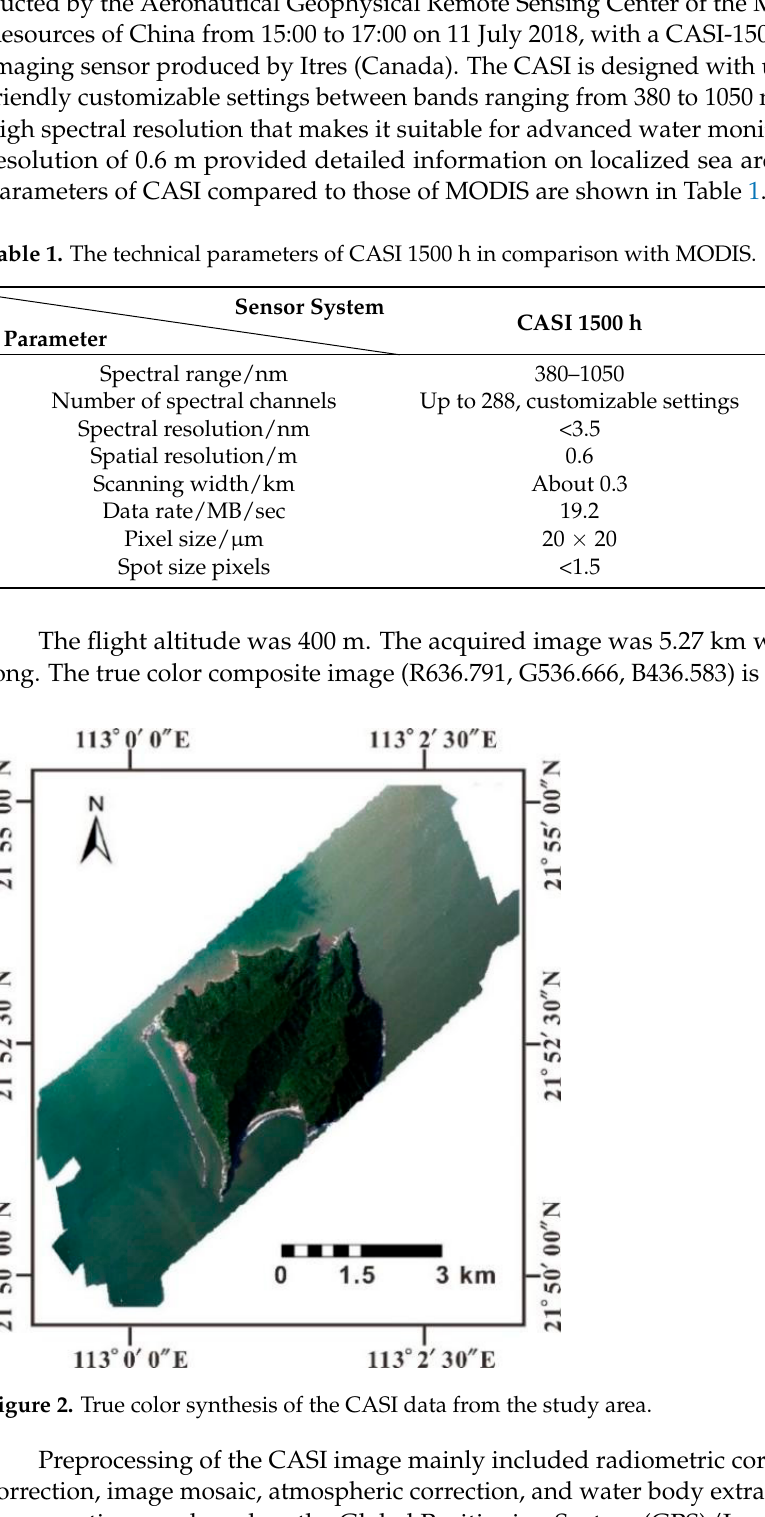
Table 1. The technical parameters of CASI 1500 h in comparison with MODIS.